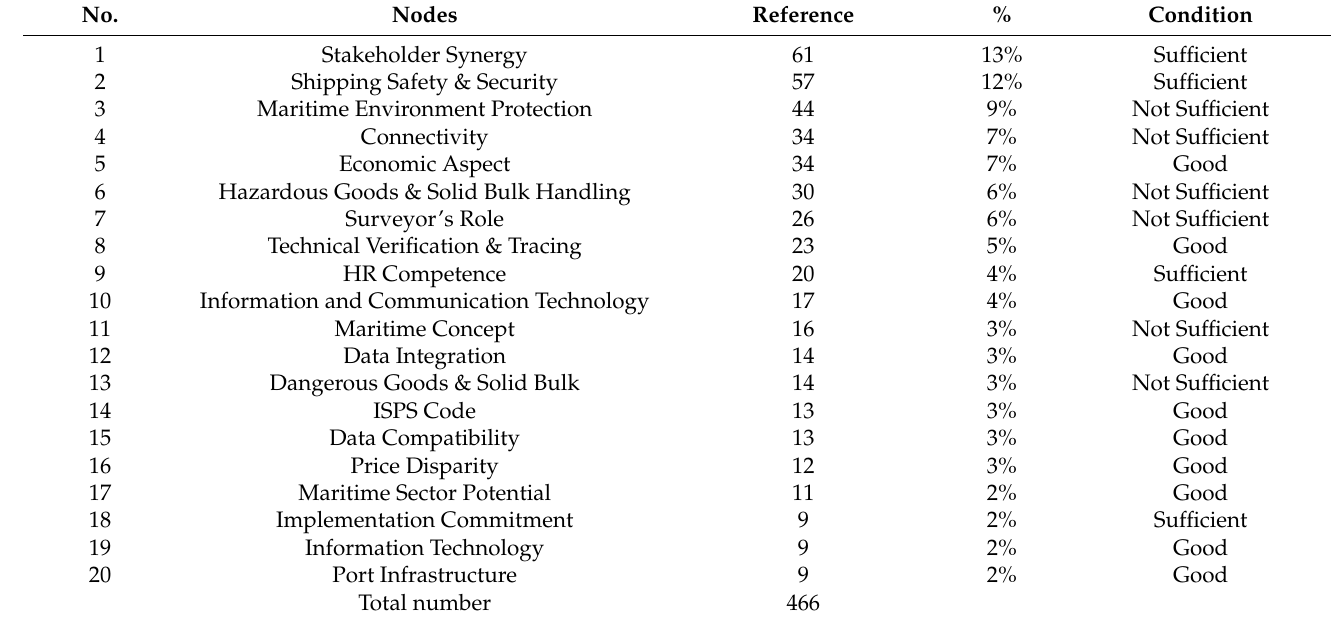
Table 2. NVivo node